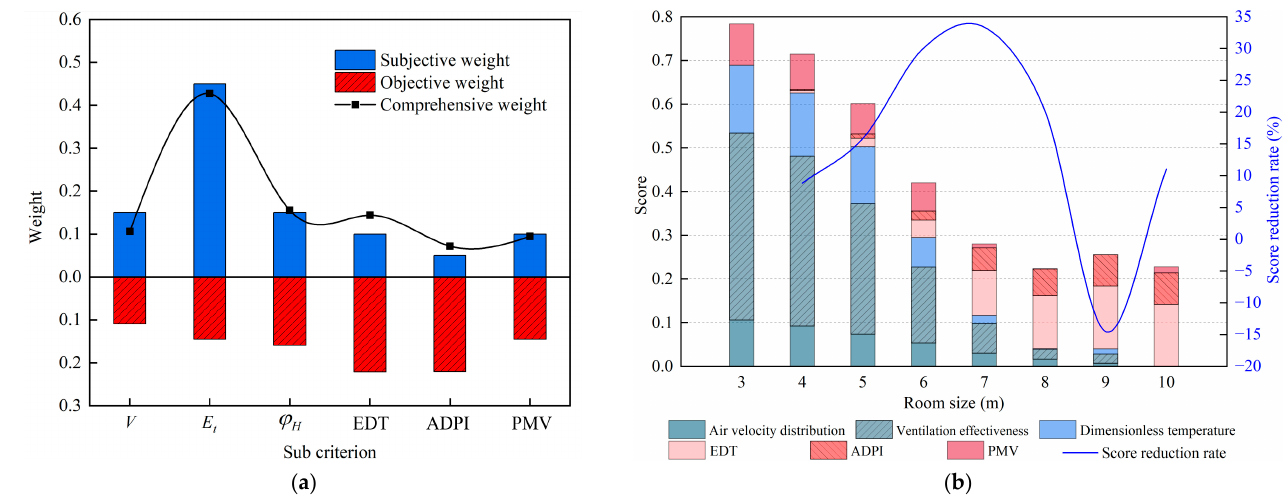
Figure 13. ( a ) Weight of the indicators; ( b ) Weight scores of different-sized rooms.